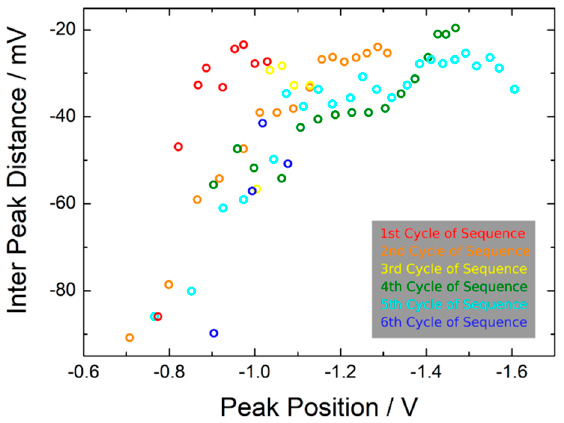
Figure 7. Data of highly dynamic SET switching patterns at negative polarity from six consecutive cycles evaluated with a view on interspike intervals (ISIs). The ISIs from the 3rd to 6th cycle of the given sequence correspond to the highly dynamic SET switching patterns presented in Figure 6.